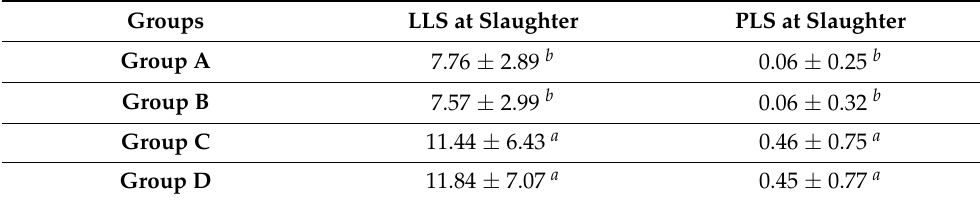
Table 6. Lung lesion score (LLS) and pleurisy lesion score (PLS) at slaughter (Mean ± SD).